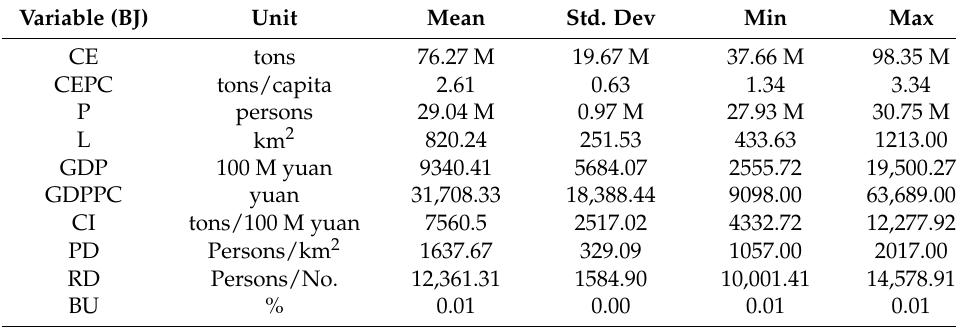
Table 5. Descriptive statistics of variables in Chongqing.